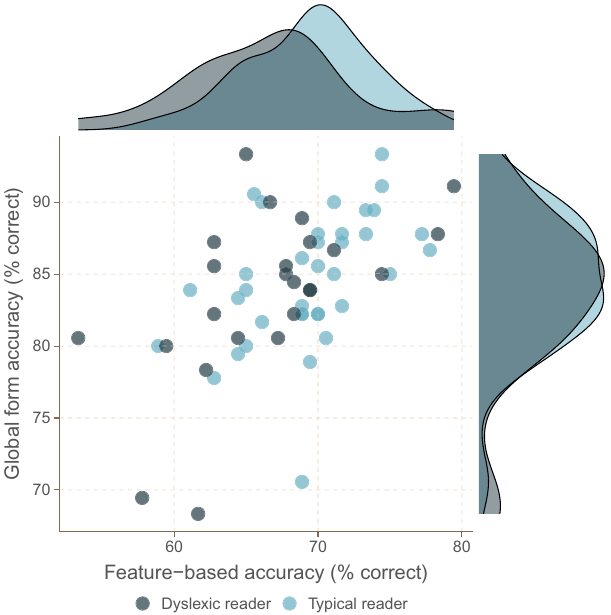
Figure 2. Performance of dyslexic (black) and typical (blue) readers on feature-based and global form face matching. Each dot corresponds to one participant. Marginal plots show density estimates for the two